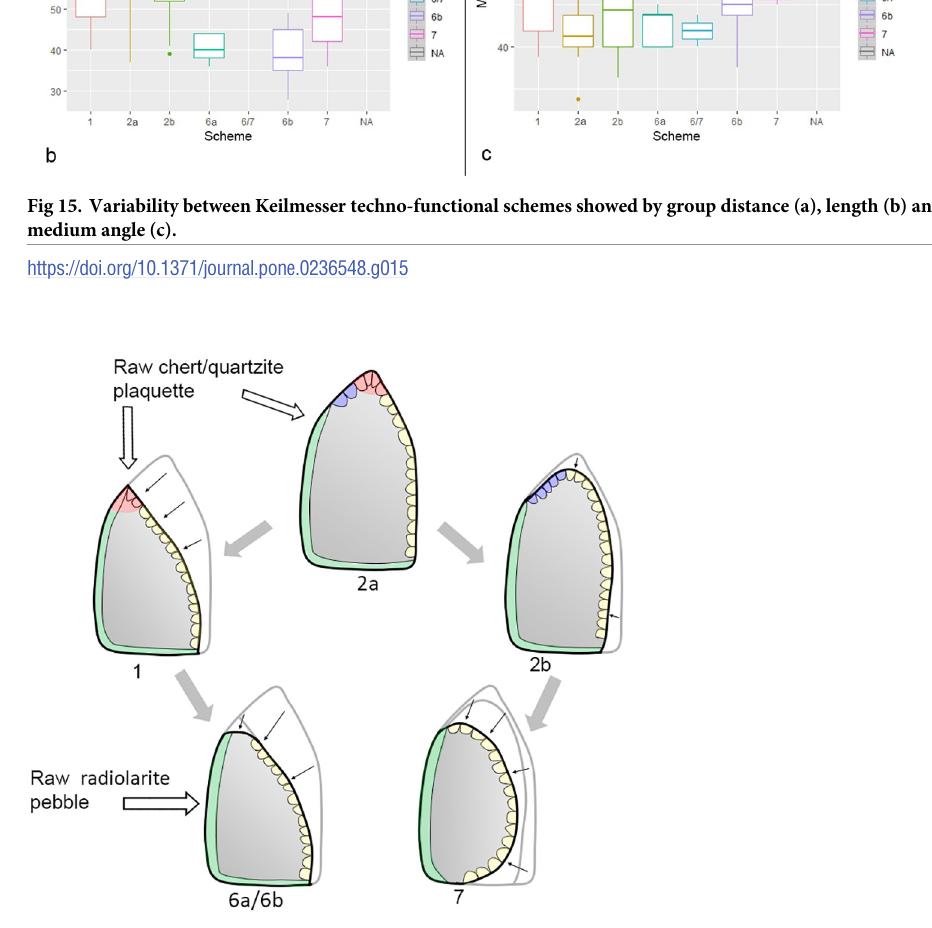
Fig 16. Hypothetical diagram proposed for the manufacturing of the different techno-functional schemes typical of Keilmesser. The nature of raw blank and their progressive modification through reduction and reshaping could have been the main reasons of this